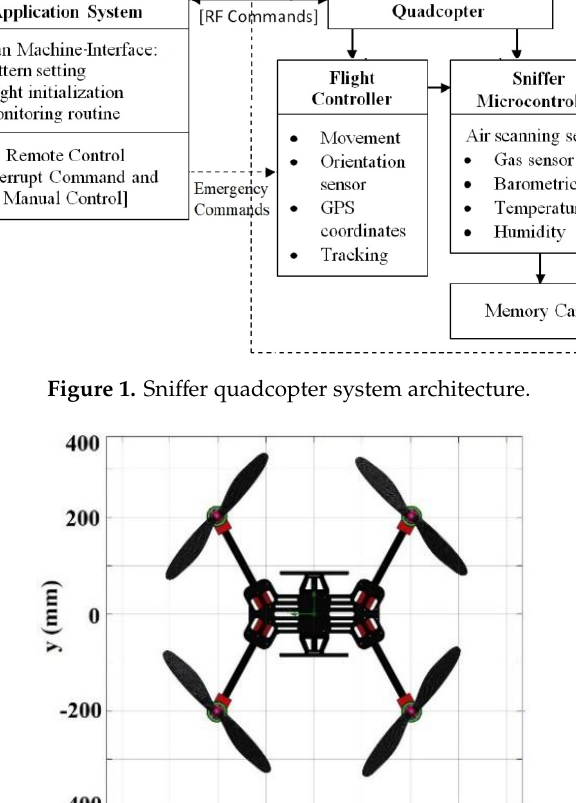
Figure 3. Air velocity dispersion. 2.2. Correlation Between Vortex Field and Sensor Position The transport of the monitored gas towards the gas sensor is a critical process to obtain accurate data which can be easily affected by the disturbances generated by the propeller ’ s vortex. Sensor position, gas distribution, and wind resistance are factors which influence the measurement results [34,35]. The downside of using a low-cost gas sensor is the low response time. To determine the sensors ’ placement, one must consider the sensors ’ response time whilst still maintaining the quadcopter stability. The use of an extended pole to place the sensors outside of propeller vortex field is not advisable because it can affect quadcopter stability. Even though it might not matter much with a small-scale sensor, an extended pole attached with a heavier sensor will surely be effect by the wind. Thus, the design and computational analysis for the gas scanning sensors ’ placement on the quadcopter ’ s frame were only tested for two points, i.e., point A and point B. Point A corresponds to the placement of the sensors at the bottom of the main frame; thus, the gas flow is not influenced by the propeller ’ s vortex. Point B corresponds to the situation in which the sensors are mounted on the front side of the frame so that the propeller ’ s vortex blows the gas directly on the sensors. Both positions were analyzed using CFD prior to the field tests. The results of the simulation process for the case of the propeller ’ s maximum angular velocity (4080 rpm) are presented